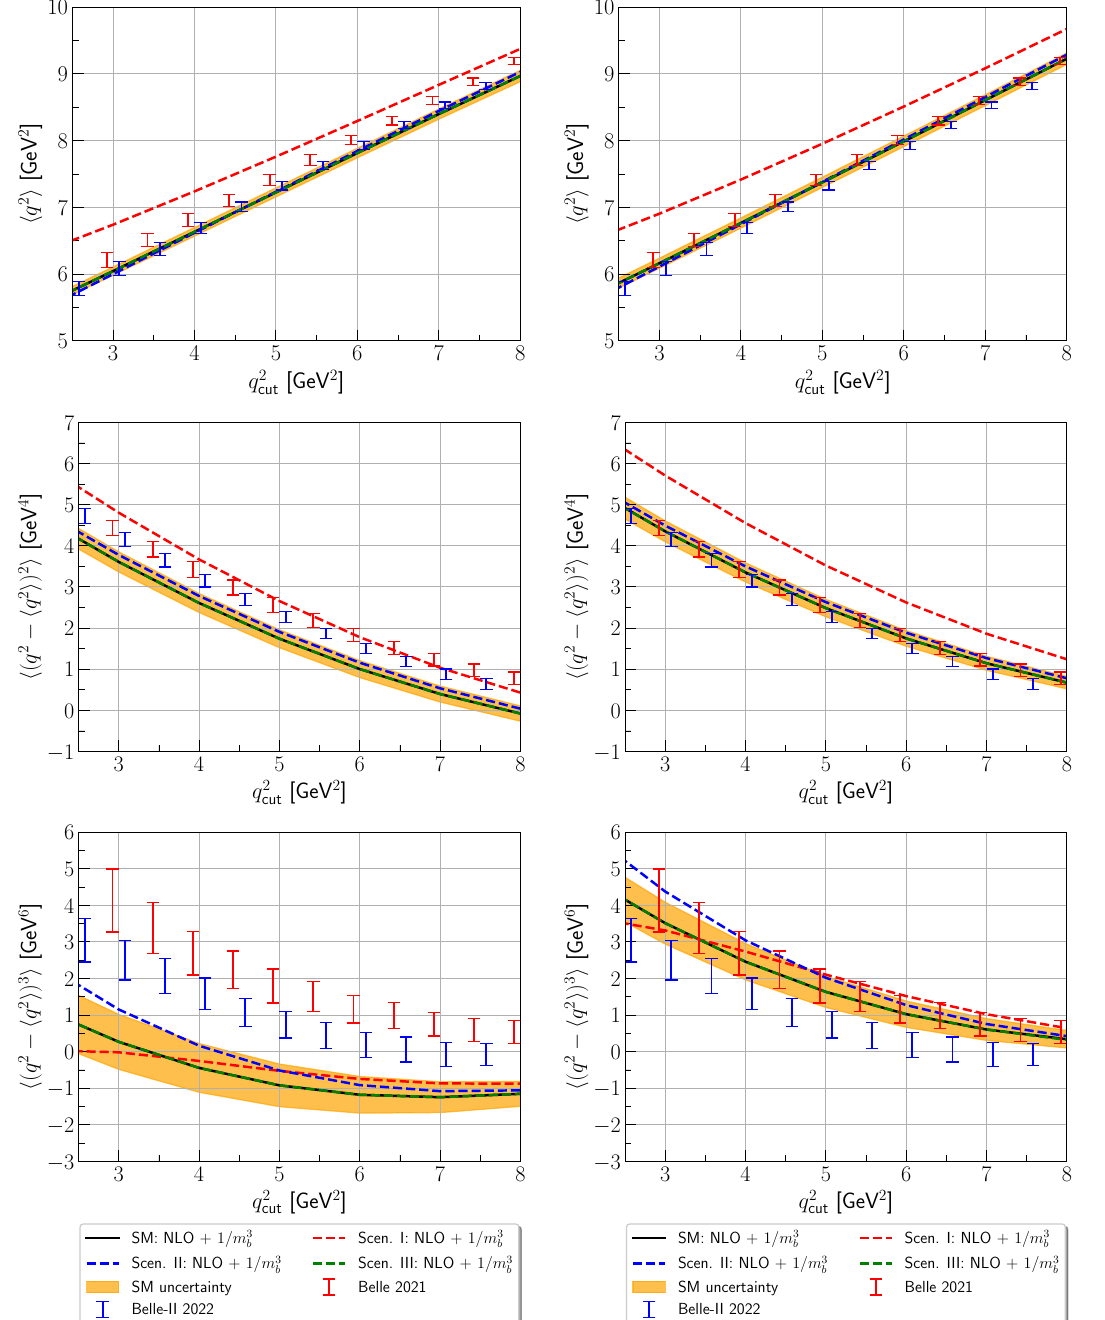
Figure 6. Dilepton invariant mass moments ( q 2 ) for the B → X c ‘ ¯ ν ‘ decay in comparison with Belle [56] and Belle II data [57]. (Left) Using the inputs in table 1 from [1](Right) using the inputs from